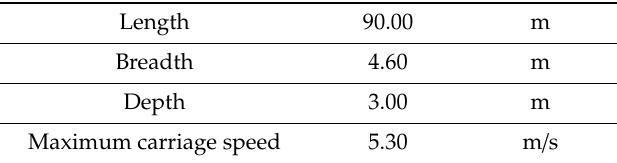
Table 4. Characteristics of NTUA towing